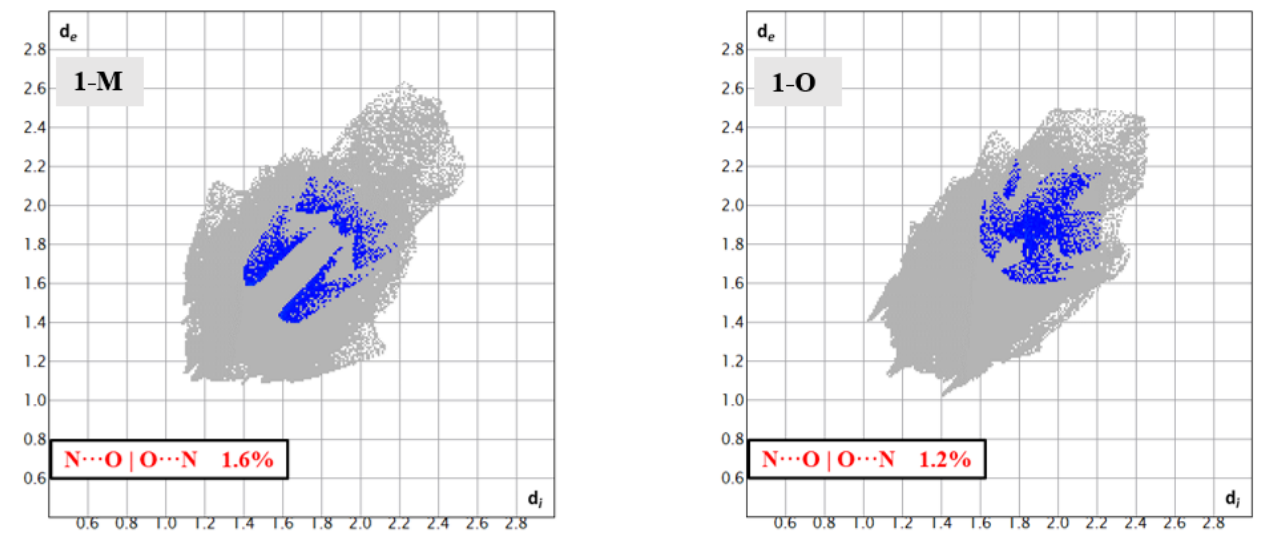
Figure 10. Fingerprints for 1-M and 1-O showing the N···O reciprocal interactions. The lower set of blue spots in 1-M are from the discussed C=O···N NO2 interactions.